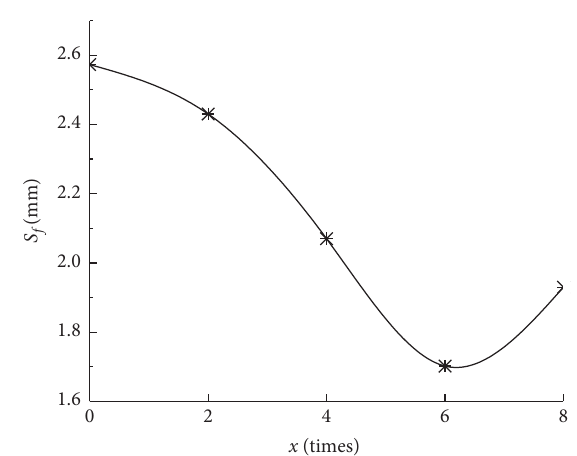
Figure 3: Relation between S